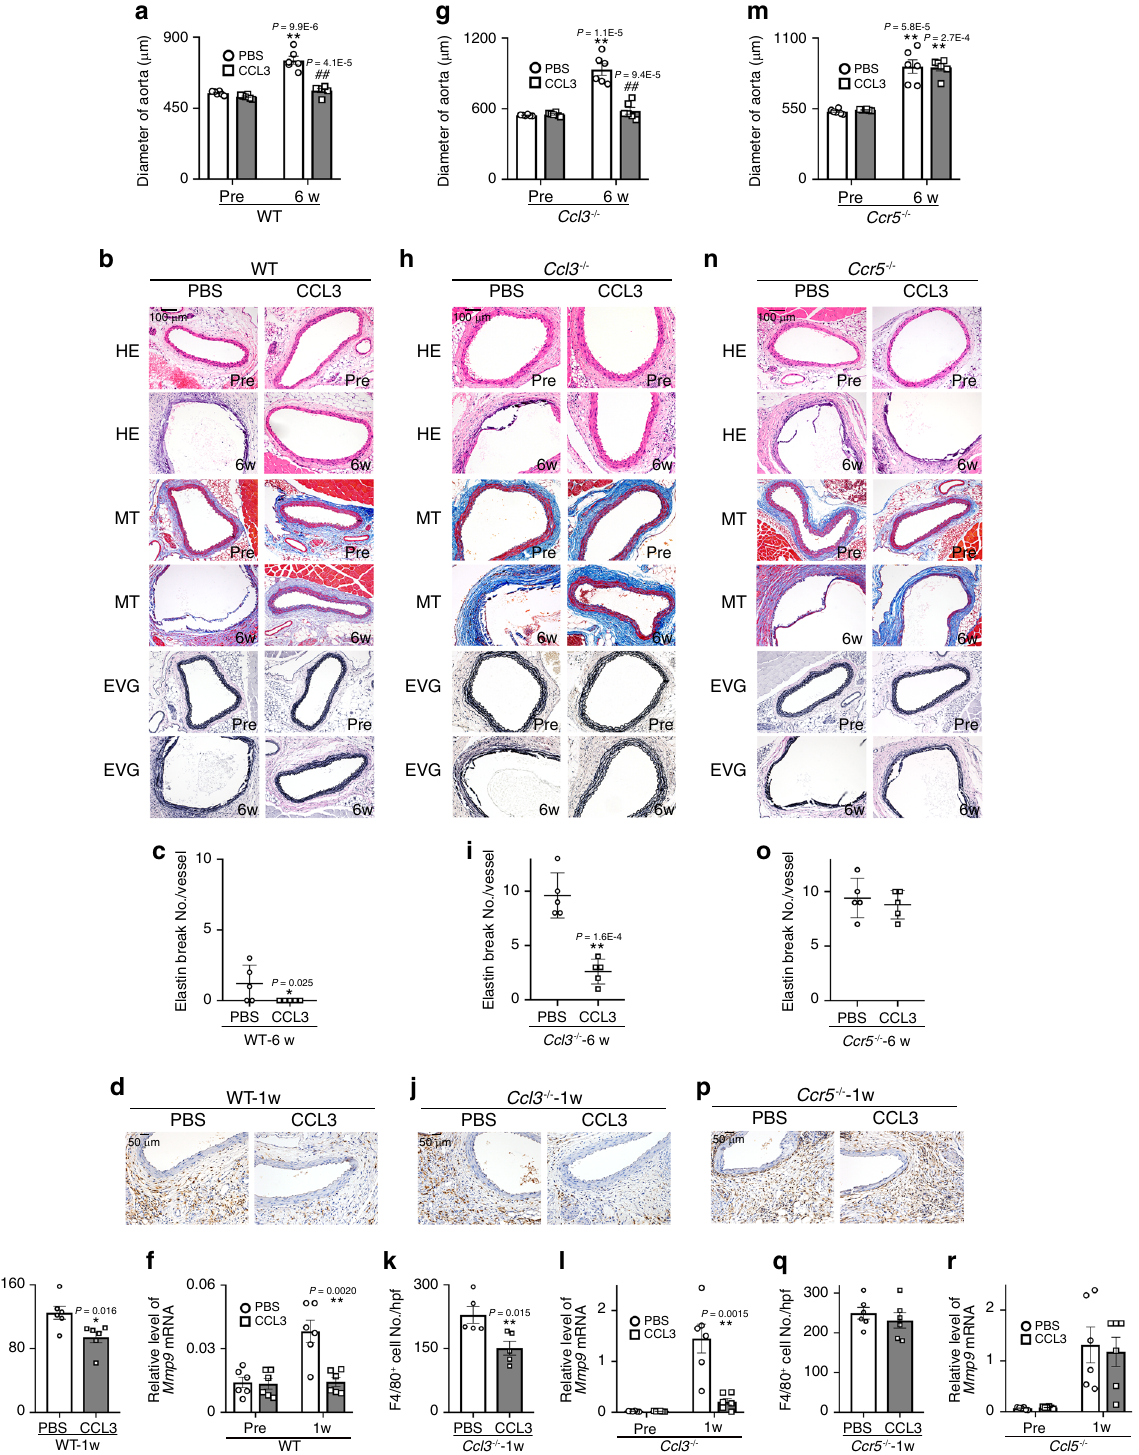
Fig. 7 Effects of CCL3 on CaCl 2 -induced AAA formation in WT, Ccl3 − / − , or Ccr5 − / − mice. a , g , m Aortic diameters before and after CaCl 2 treatment ( n = 6 each in all groups). ** P < 0.01, * P < 0.05, vs. pretreatment in each strain; ## P < 0.01, CCL3 vs. PBS treatment. b , h , n Histopathological analysis of the aortas obtained from WT, Ccl3 − / − , and Ccr5 − / − mice after CaCl 2 treatment. Representative results from fi ve independent experiments are shown here. Scale bars, 100 μ m. c , i , o Quanti fi cation of the number of elastin breaks per vessel ( n = 5 each in all groups). * P < 0.05, ** P < 0.01, vs. PBS. d , j , p The effects of CCL3 on macrophage accumulation into aortic tissues after CaCl 2 treatment. Representative results from six independent experiments are shown. Scale bars, 50 μ m. e , k , q Macrophage numbers were measured. ( e , q : n = 6 samples in all groups; k : n = 5 samples in all groups). ** P < 0.01, * P < 0.05, vs. PBS-treated mice. f , l , r Intra-aortic Mmp9 expression in CaCl2-treated WT, Ccl3 − / − or Ccr5 − / − mice after CCL3 treatment ( n = 6 samples in all groups). ** P < 0.01, vs. PBS-treated mice. Unpaired two-sided Student ’ s t test was used in ( a ), ( c – f ), ( g ), ( i – l ), ( m ), and ( o – r ). Data are presented as mean values ±